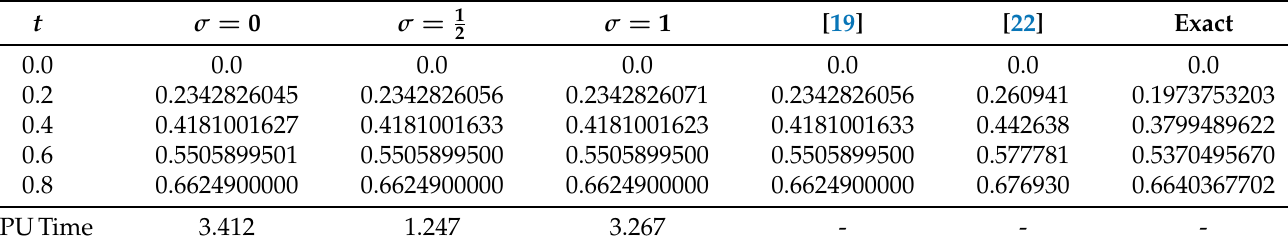
Table 1. Comparison between our method [19,22], methods for φ ( t ) of Example 1, with n = 15, α = 0.9, β = 1 and ρ = 1.01.